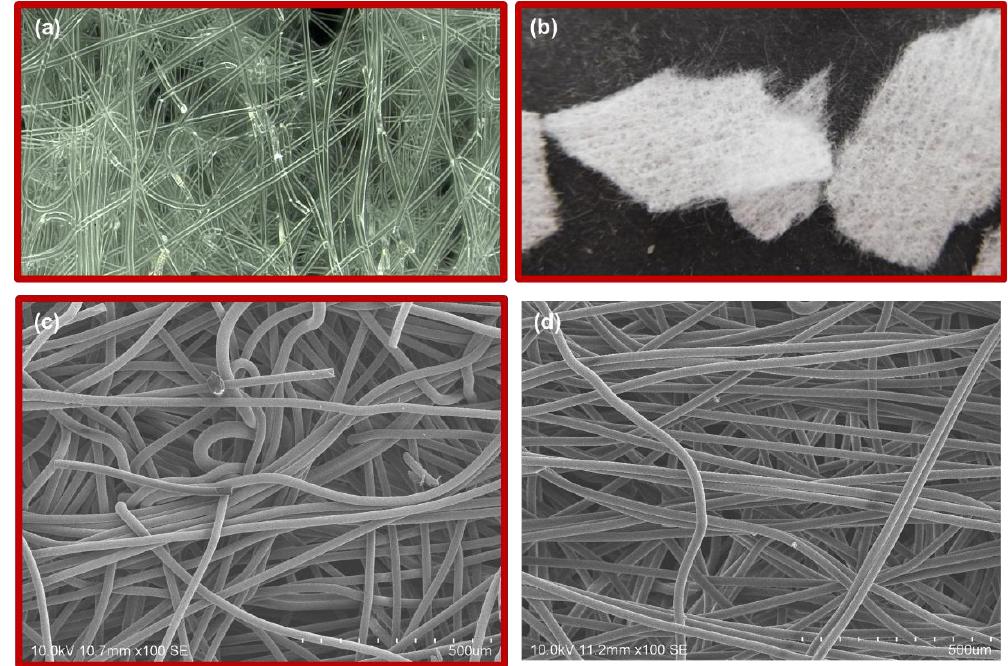
Figure 6. ( a ) 3D optical microscopy, ( b ) macroscopic photo of the fabric NW-L pieces treated at 80 °C and 80% RH for 7 days. ( c , d ) SEM images of the fibers after and before the aging, respectively, with the aged sample revealing numerous broken ends.